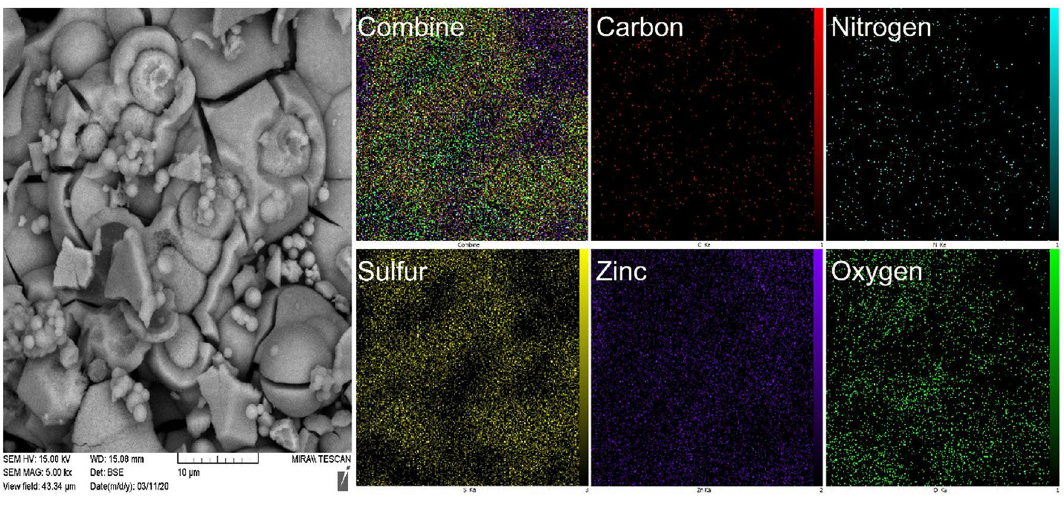
Figure 5. X-ray mapping analysis of